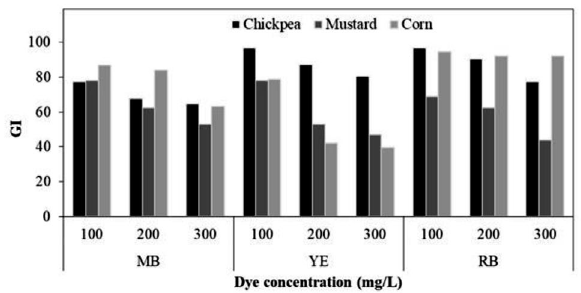
Fig. 4 . Germination indices for chickpea, mustard and corn plant seeds after 5